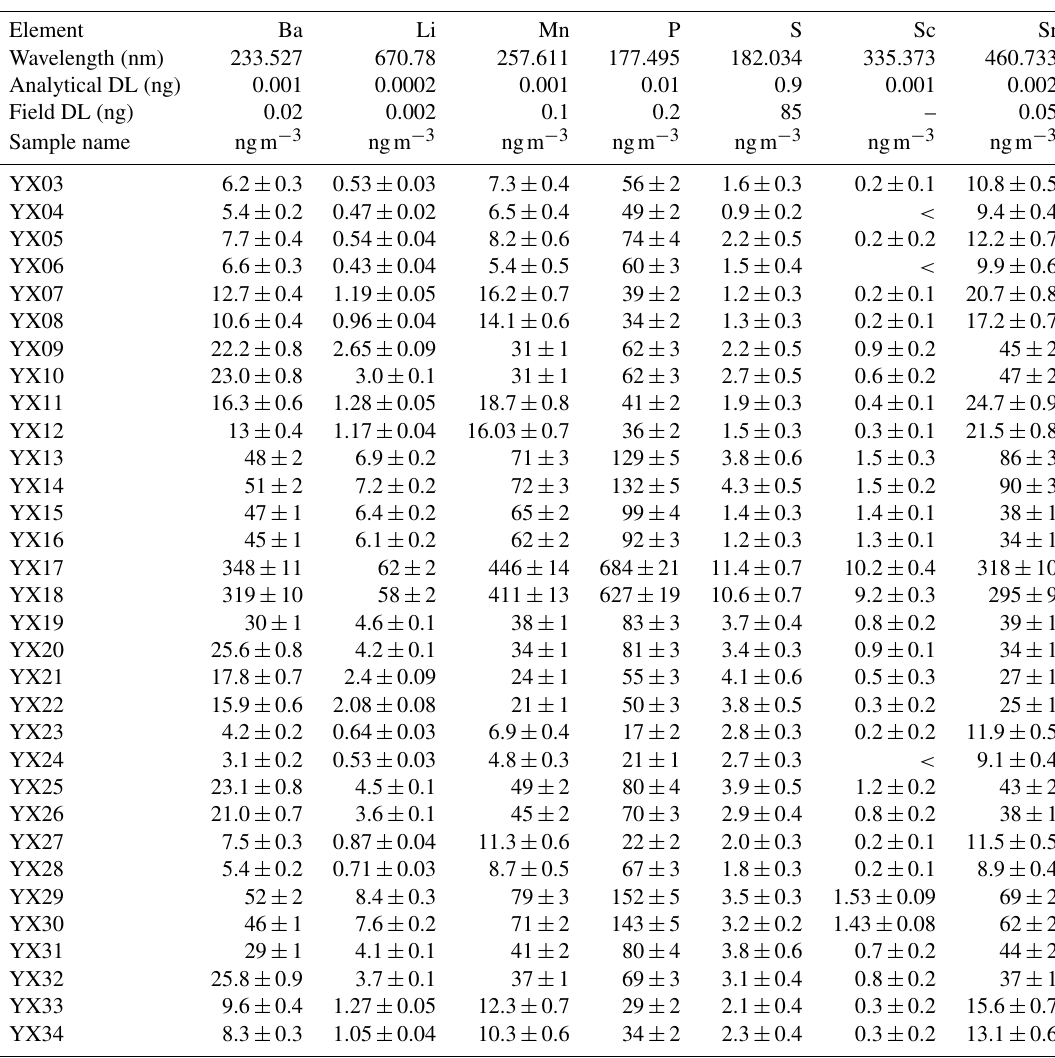
Table A2. Elemental air concentrations measured with ICP-AES,